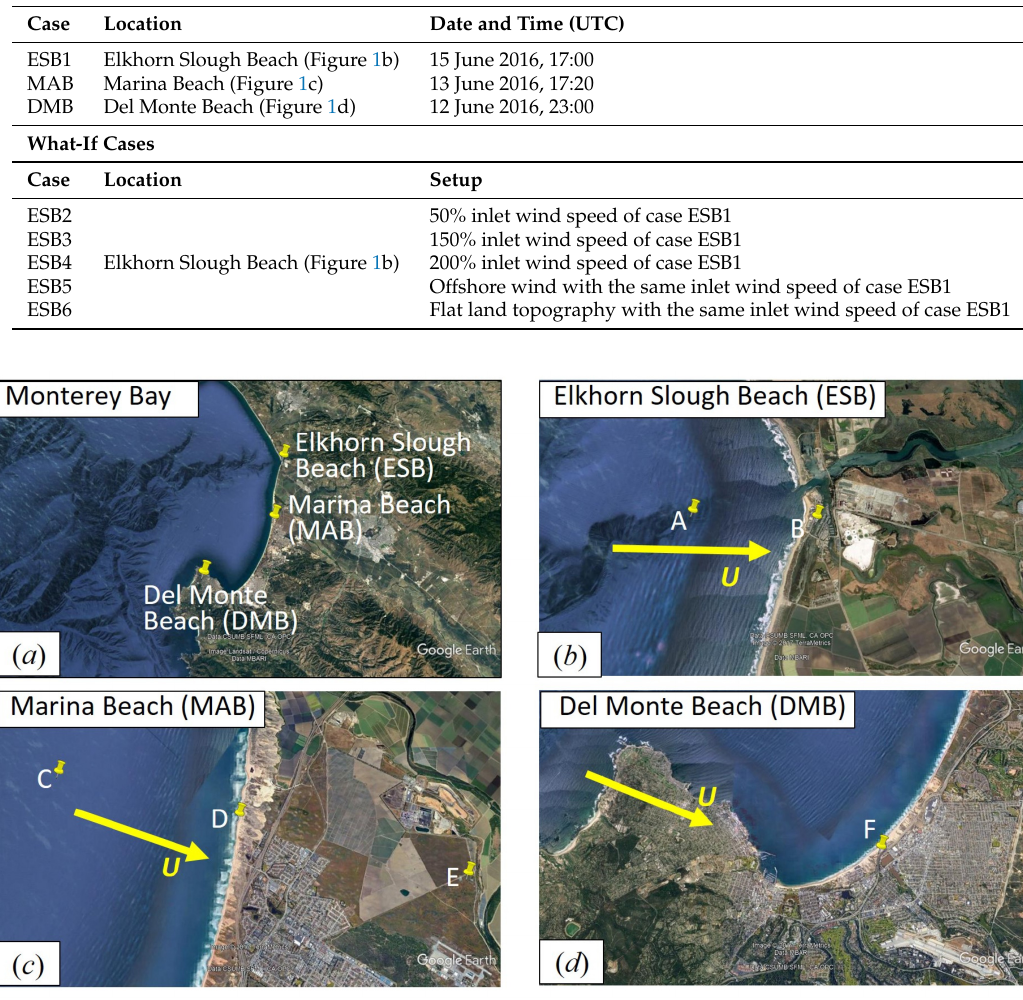
Figure 1. Locations of simulation cases obtained from Google Earth. ( a ) Monterey Bay, ( b ) Elkhorn Slough Beach (ESB), ( c ) Marina Beach (MAB), ( d ) Del Monte Beach (DMB). The arrows represent the wind direction. The large-eddy simulations (LES) results are validated against measurement data at locations ( A – F ) at three different beaches as marked in ( b – d